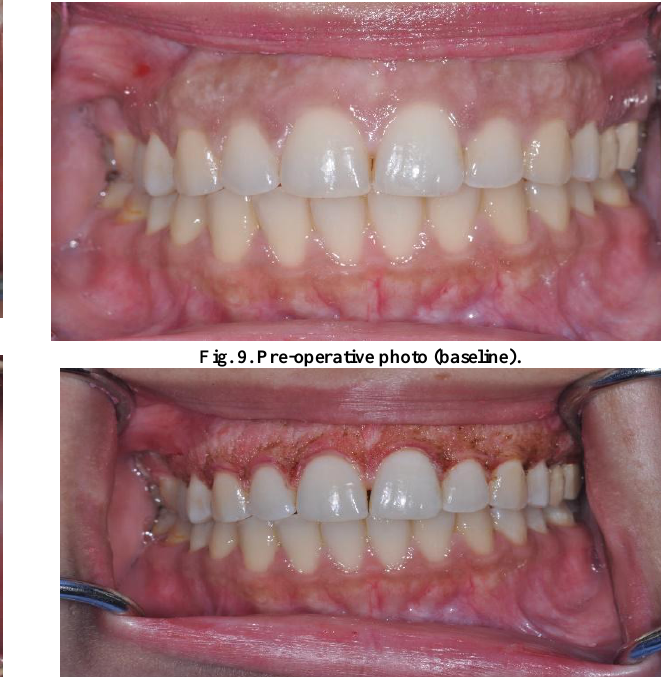
Fig. 5. Pre-operative photo (baseline).